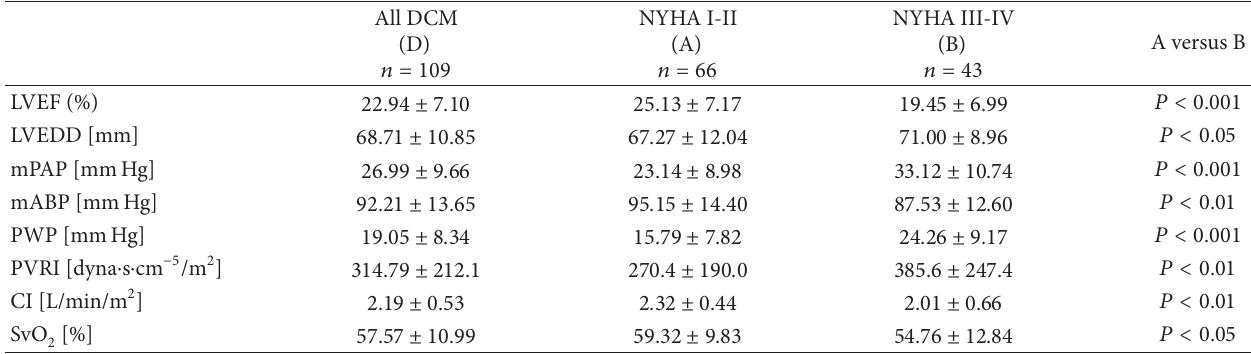
Table 3: Results of selected echocardiographic and haemodynamic parameters in all patients and with division into groups depending on NYHA